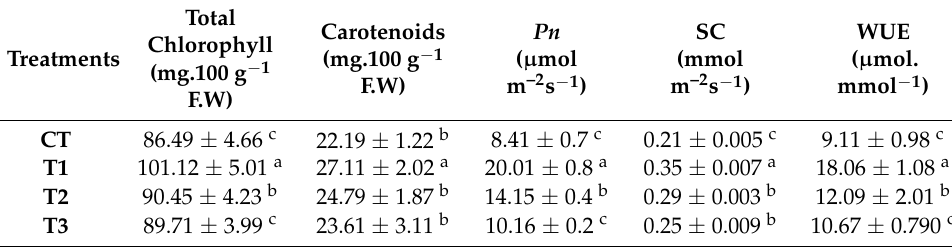
Table 2. Impacts of diverse iron sources (nano, chelate, and sulfate), as foliar spray on photosynthetic pigments and photosynthesis apparatus of Vicia faba plants.